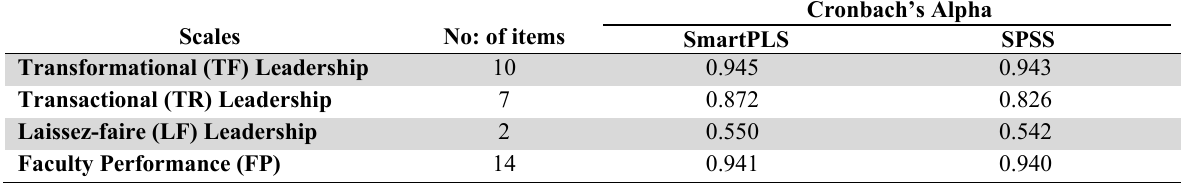
Comparison between the results of Cronbach’s Alpha in SmartPLS and